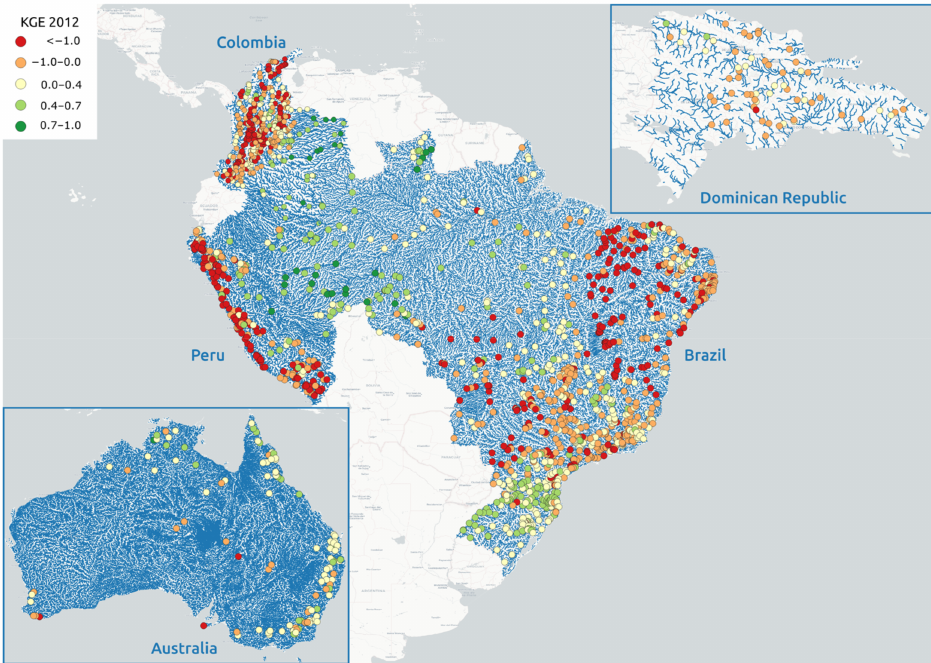
Figure 10. KGE-2012 error metric computed for the difference between the original historical simula- tion and the observed data for Australia, Brazil, Colombia, the Dominican Republic, and